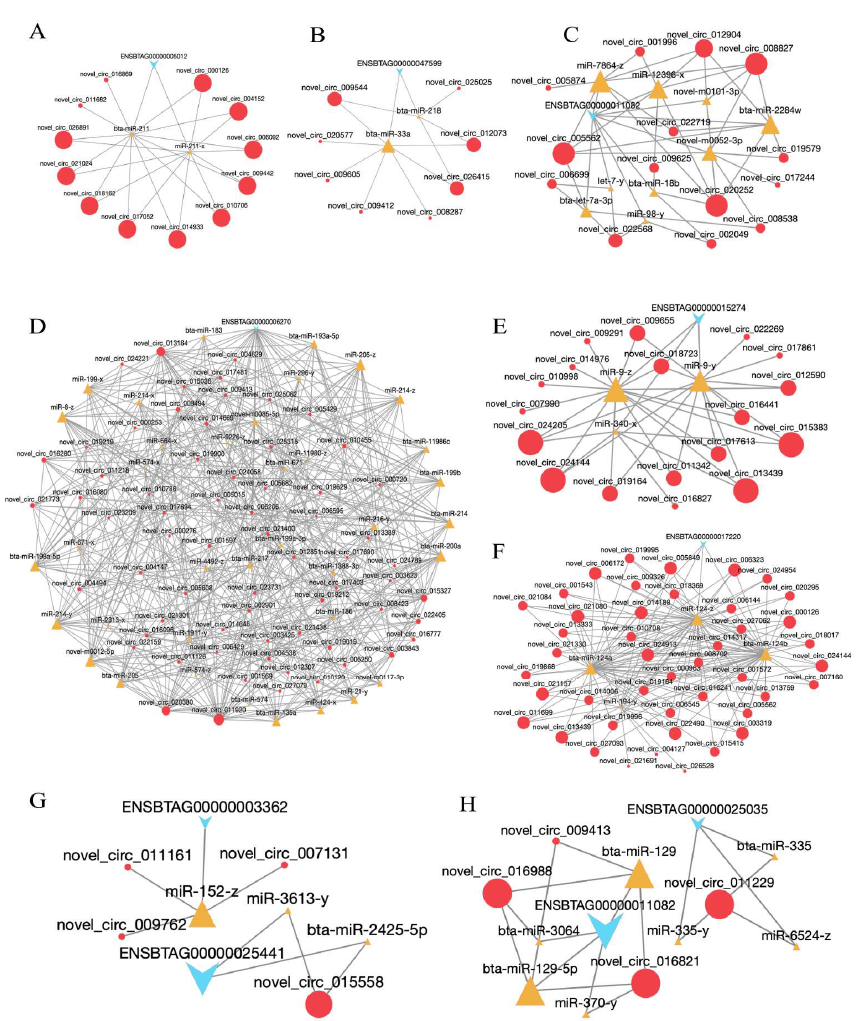
Figure 8. ceRNA regulatory networks in HPM axis of dairy cows under heat stress. ( A , B ) Subnetwork of HSPH1 and GHRHR in hypothalamus. ( C – F ) Subnetwork of IGF1 , HSP90AA1 , PRL , and GH1 in pituitary. ( G , H ) Subnetwork of HSP90B1 , HSPA1A , PRLR and IGF-1 in mammary gland.